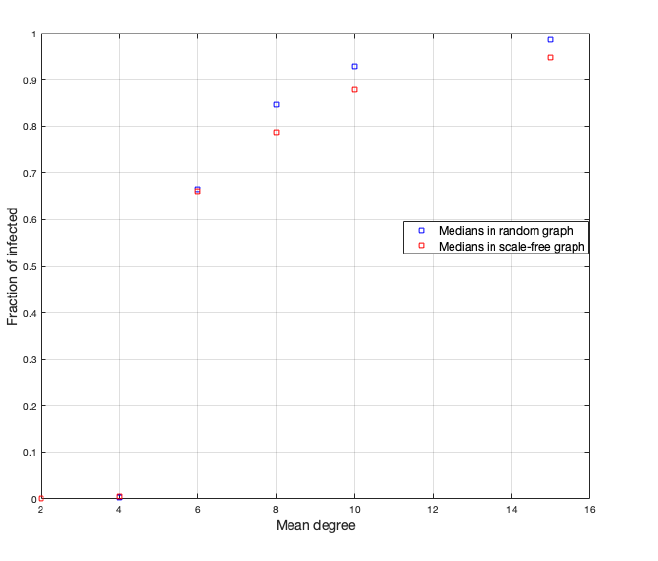
Figure 9. Median for random and scale-free graph in fraction of